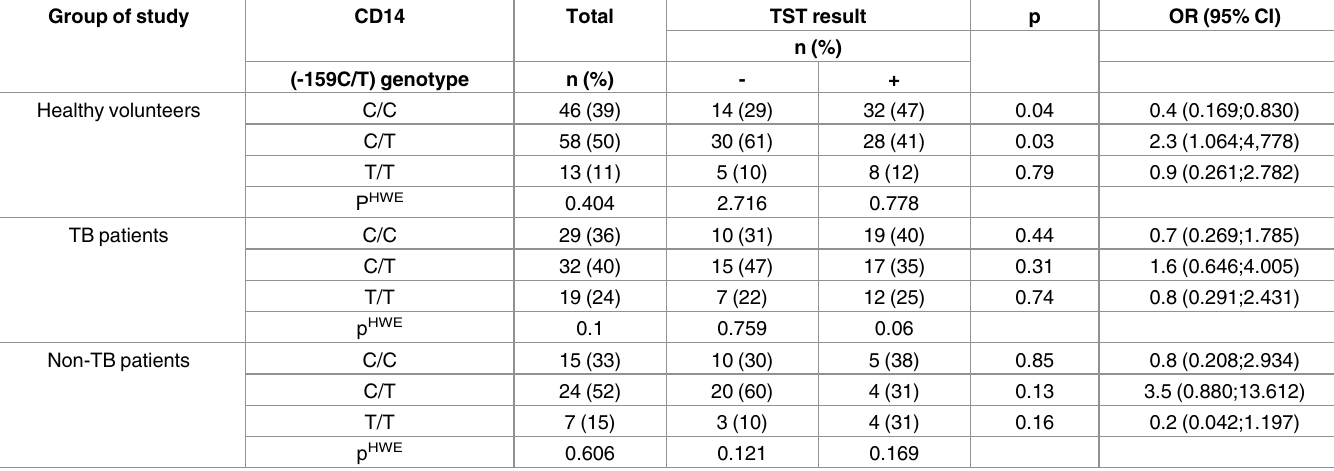
Table 4. Frequency of CD14(-159C/T) genotypes in TST(-) and TST(+) individuals from the studied groups. Group of